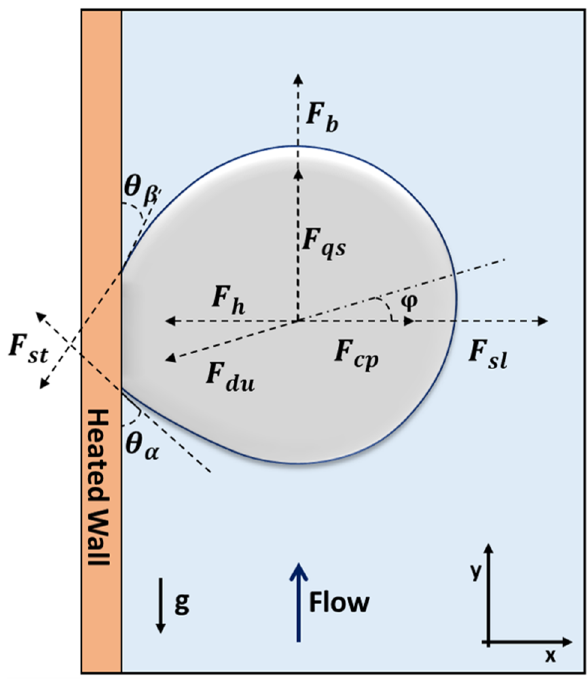
Figure 1. Schematic of forces acting on a